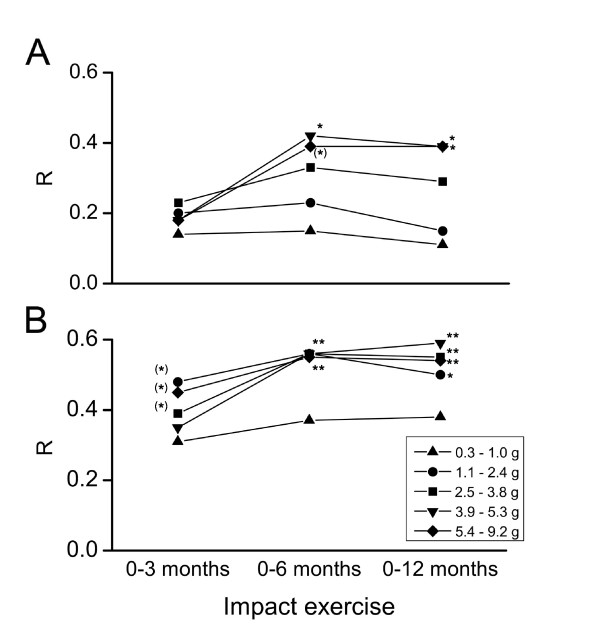
Correlation between impact exercise at different time intervals and 12-month aBMD changes in proximal femur. Pearson's correlation coefficients (r) between the impact exercise at different acceleration levels in 0-3, 0-6 and 0-12 months, and yearly aBMD changes A) in the femoral neck, and B) trochanter. N = 34 (DXA data was missing from one subject), g = acceleration of gravity (9.81 m·s-2), * p < 0.05, ** p < 0.01 after Benjamini-Hochberg corrections, (*) the association did not remain significant after adjustment for impacts at later months in multivariate analysis.